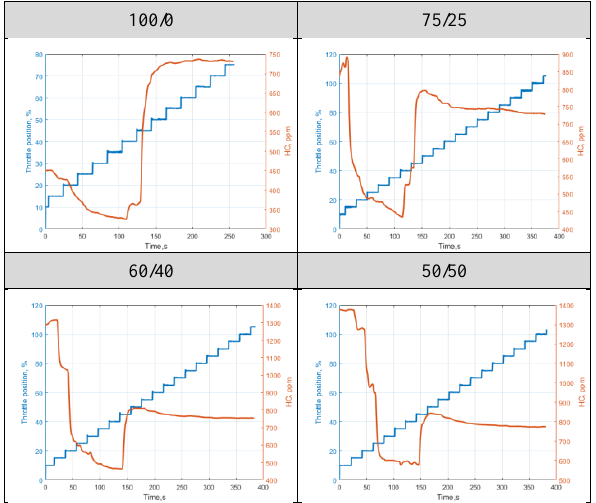
Fig. 8. Concentration of HC in the exhaust gases at supply of different gas mixture